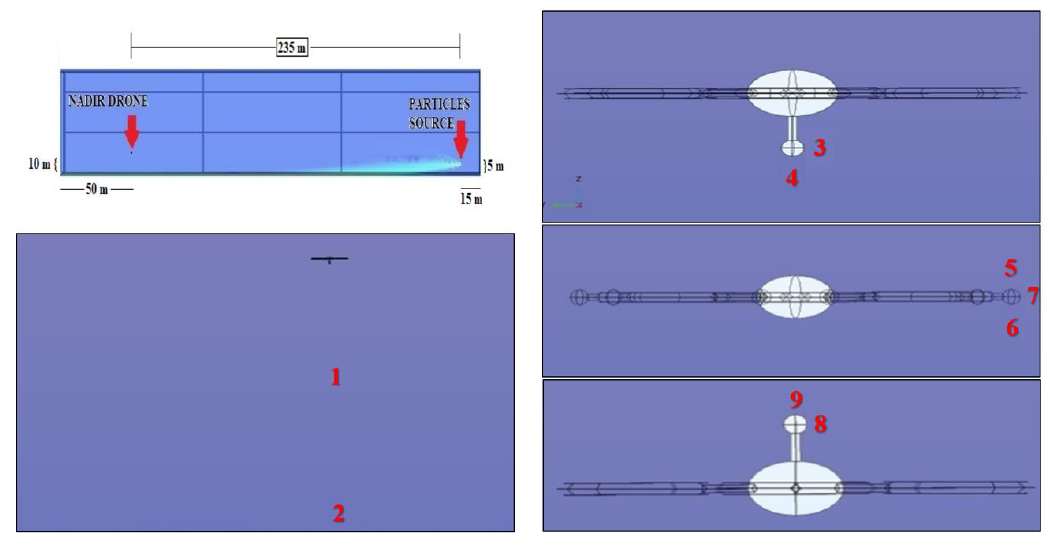
Figure 6. Schematics of the drone-sphere geometry, concentration field, and point analyzed in the numerical set 10-235-5.